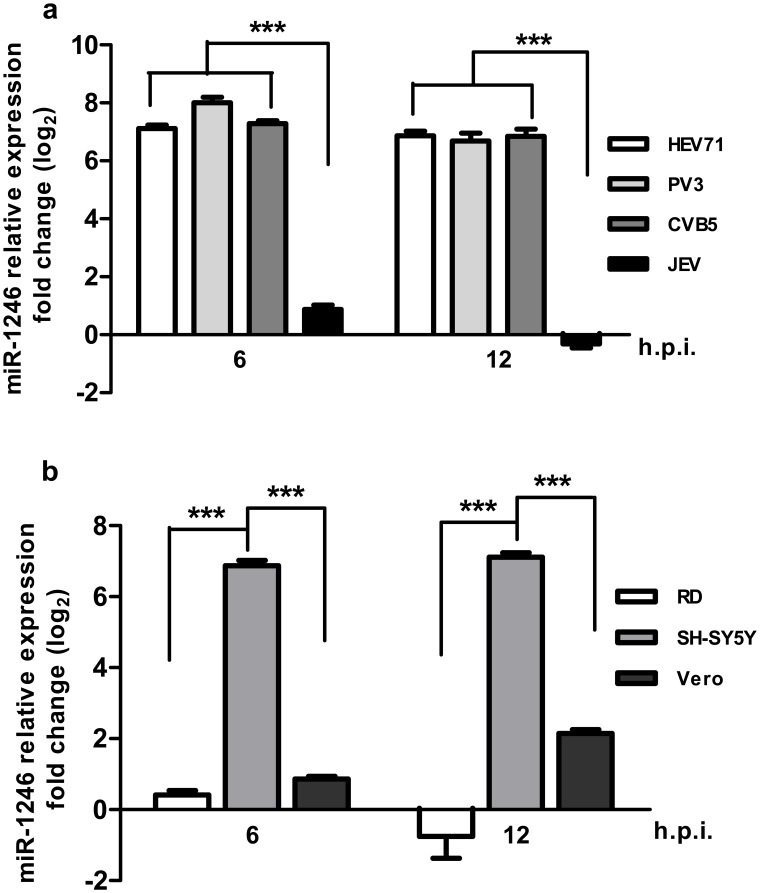
miR-1246 is specially induced in enterovirus-infected SH-SY5Y cells.
a. SH-SY5Y cells were infected with HEV71, PV-3, CV-B5, and JEV, respectively, and the expression of miR-1246 was detected by qRT-PCR. b. SH-SY5Y cells, RD cells, and Vero cells were infected with HEV71 and subjected to qRT-PCR analysis for miR-1246. All data are normalized against a mock-infected sample. ***P<0.0001; values represent the mean±SD.